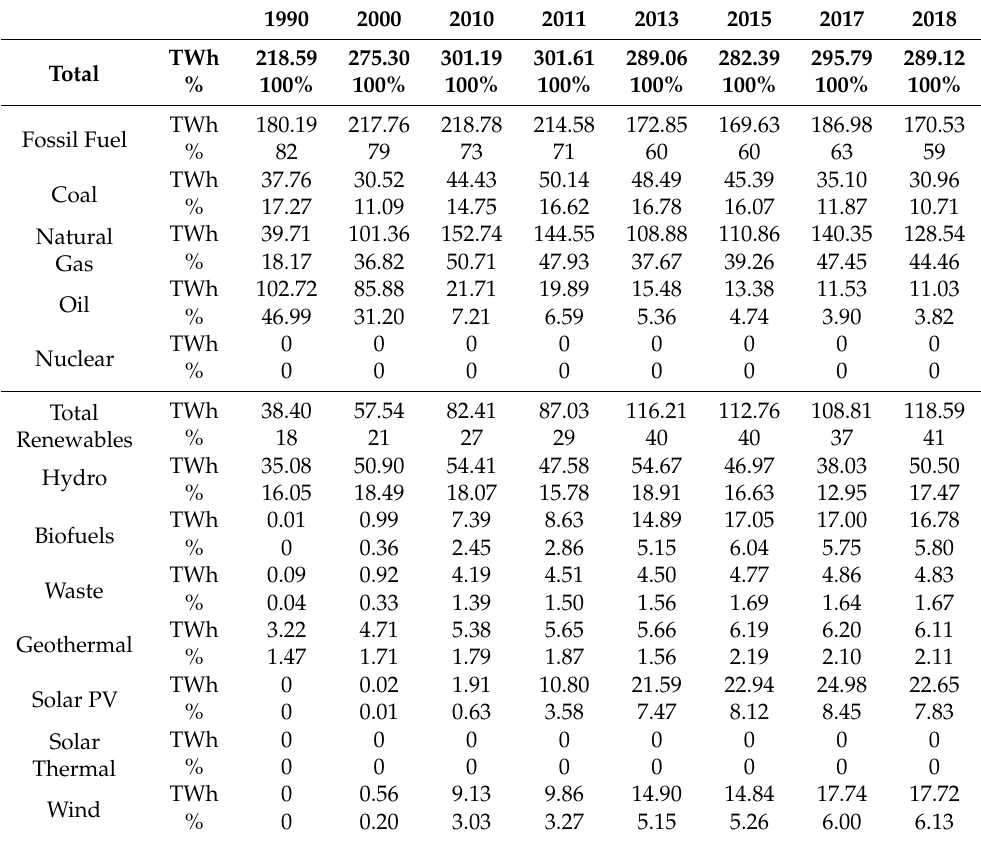
Table 1. Italian electricity production by source